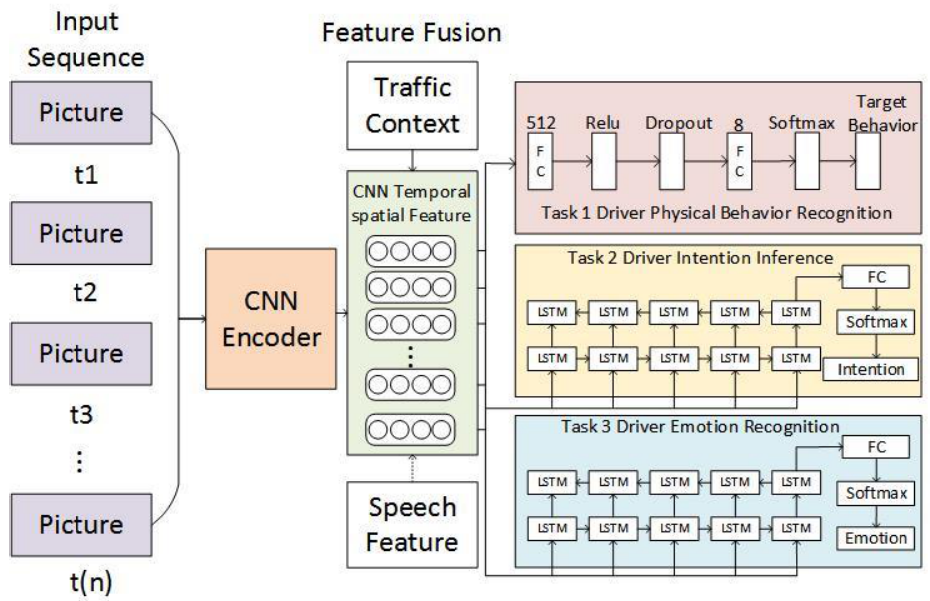
Figure 5. Multi-task learning model framework.